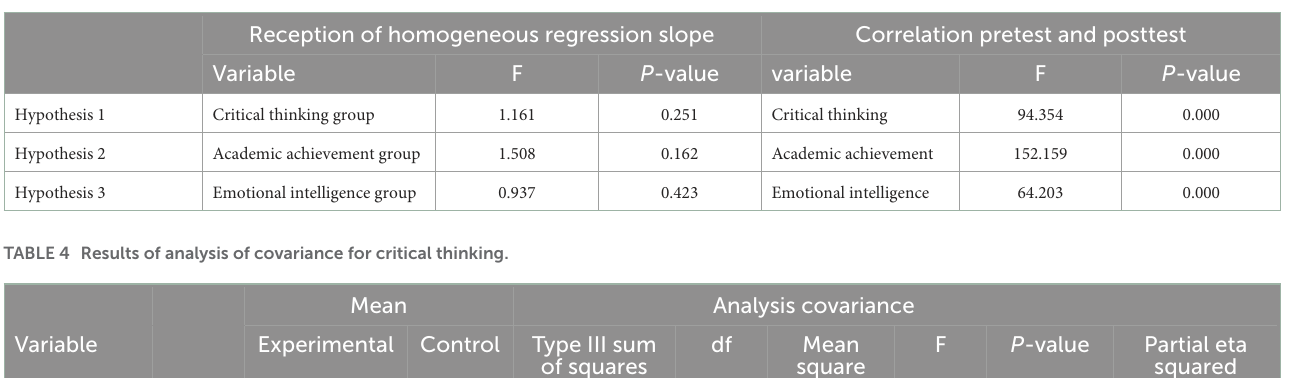
TABLE 3 Reception of homogeneous regression slope.